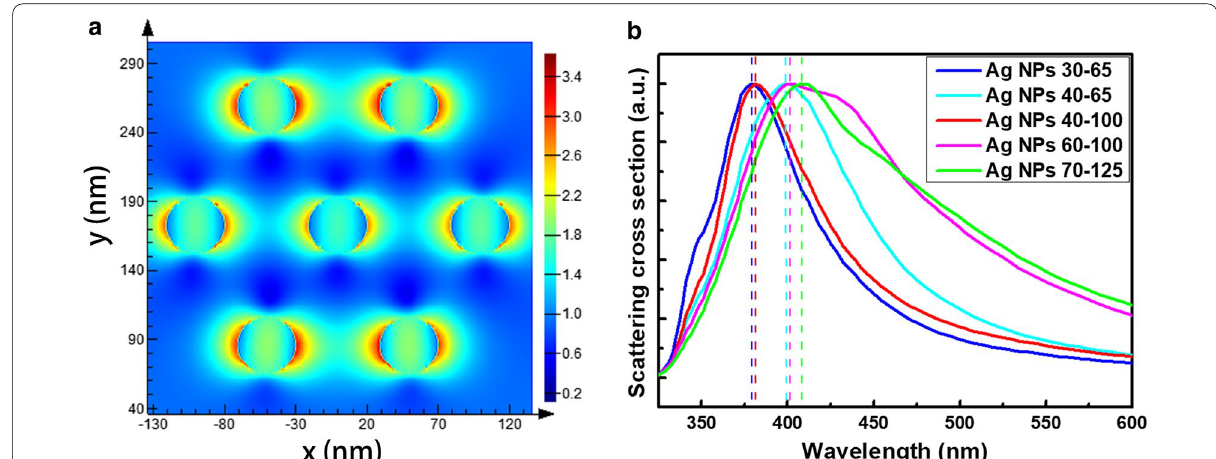
Fig. 2 a Simulated spatial electric field distribution in the sample 4 with the diameter of 40 nm and space of 100 nm. b Normalized scattering cross section spectra of Ag NP arrays with different diameters and